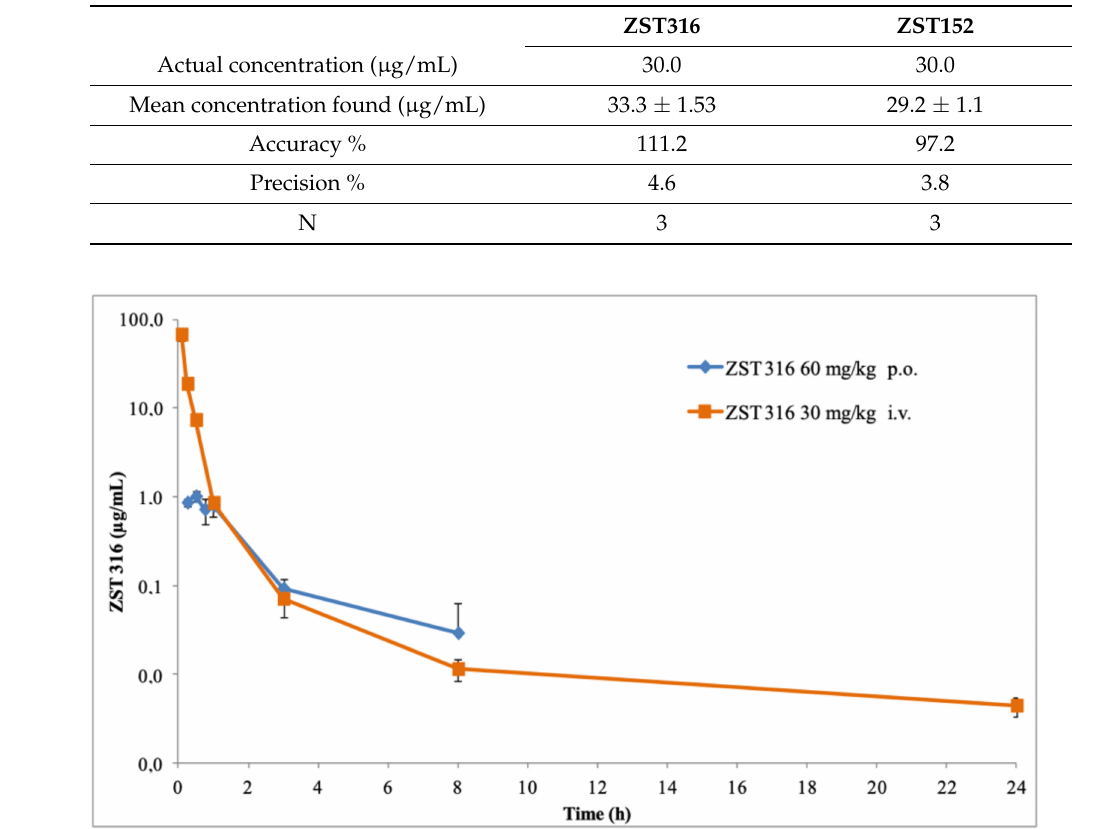
Table 4. Intra-day precision and accuracy results for ZST316 and ZST152 in urine.